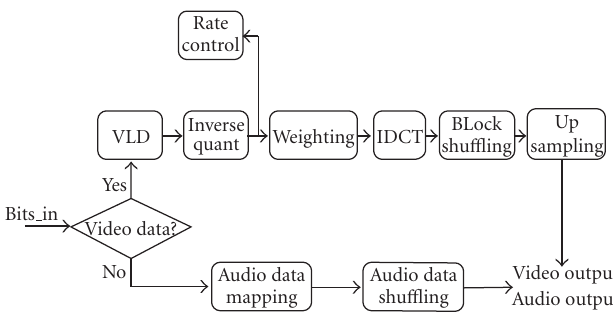
Figure 2: DV decoder data processing block